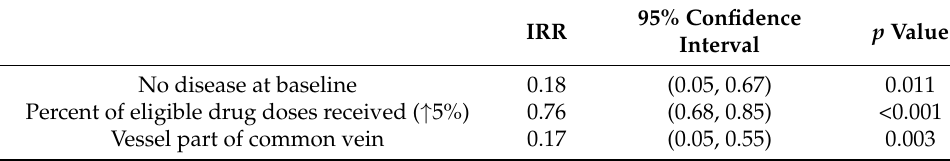
Table 7. Rate of reintervention during the study period: multivariable